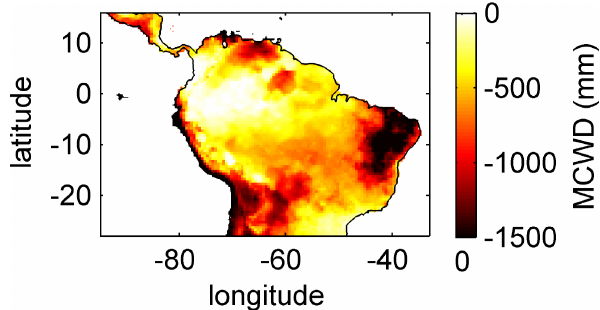
Figure B2. Mean annual MCWD for 2001–2010 under CRU cli- mate